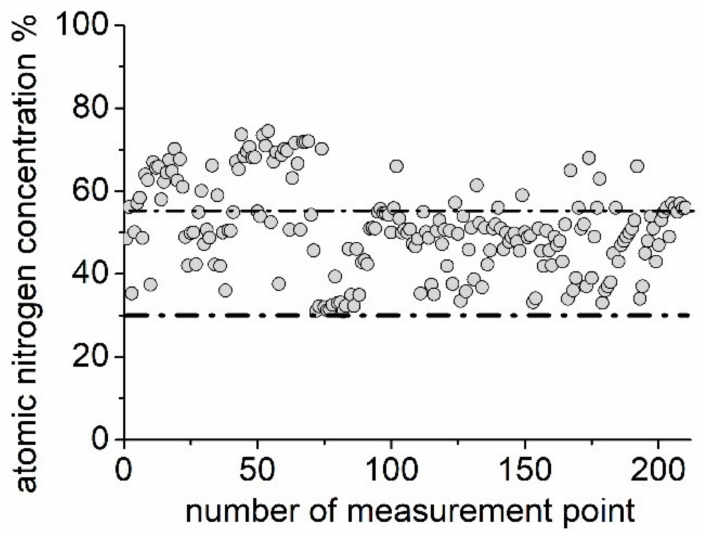
Figure 10. Content of nitrogen in titanium nitride according to XRD micro-analysis of mechanically activated titanium powder in nitrogen after 20 min